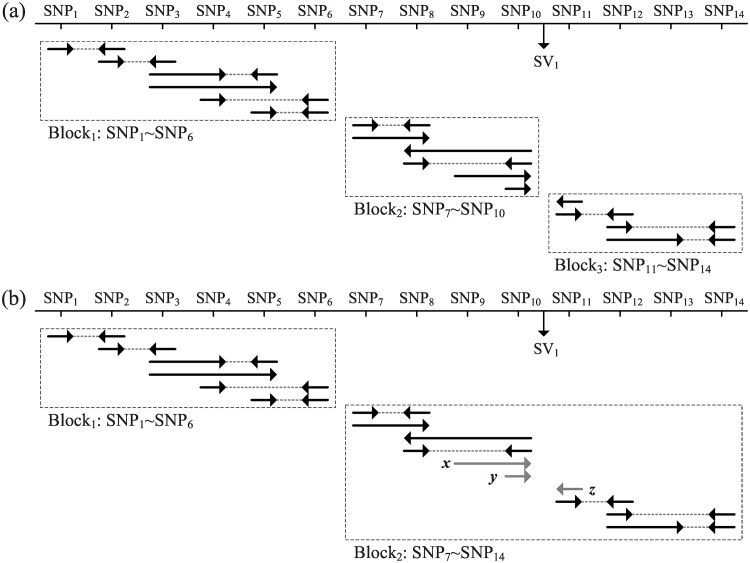
Illustration of extended Haplotype blocks via heterozygous SVs.One end is represented by a solid arrow and two ends from the same read are connected by a dotted line. There is a heterozygous SV1 between SNP10 and SNP11. (a) Without considering SVs, the entire haplotype will be broken into three haplotype blocks; (b) In our approach, Block2 and Block3 in (a) are merged by bridging read x, y in Block2 and bridging read z in Block3 that indicate heterozygous SV1.